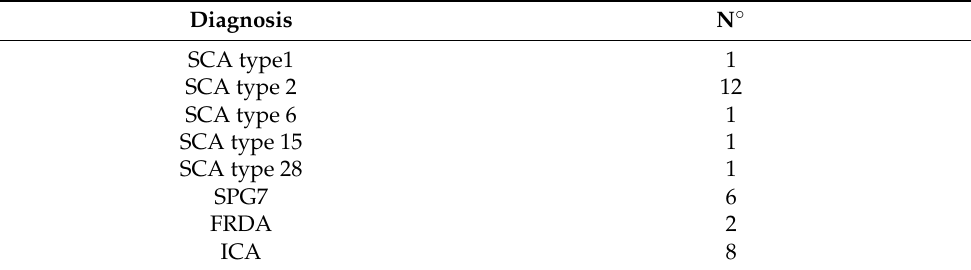
Table 4. Clinical details regarding the CD